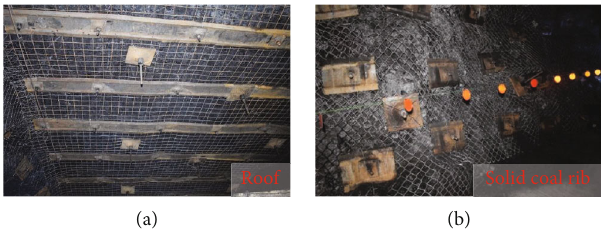
Figure 11: Photos of the roadway roof during excavation: (a) roadway solid coal rib and (b) roadway roof.